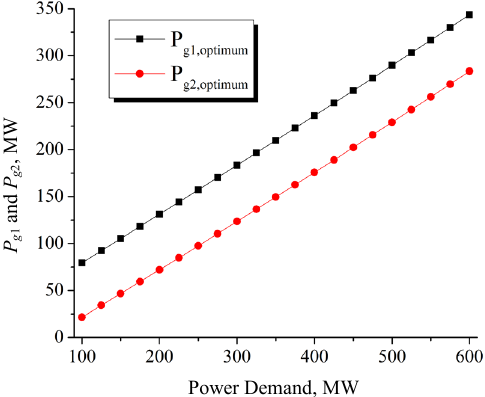
Fig. 5. Power division vs power demand between generating